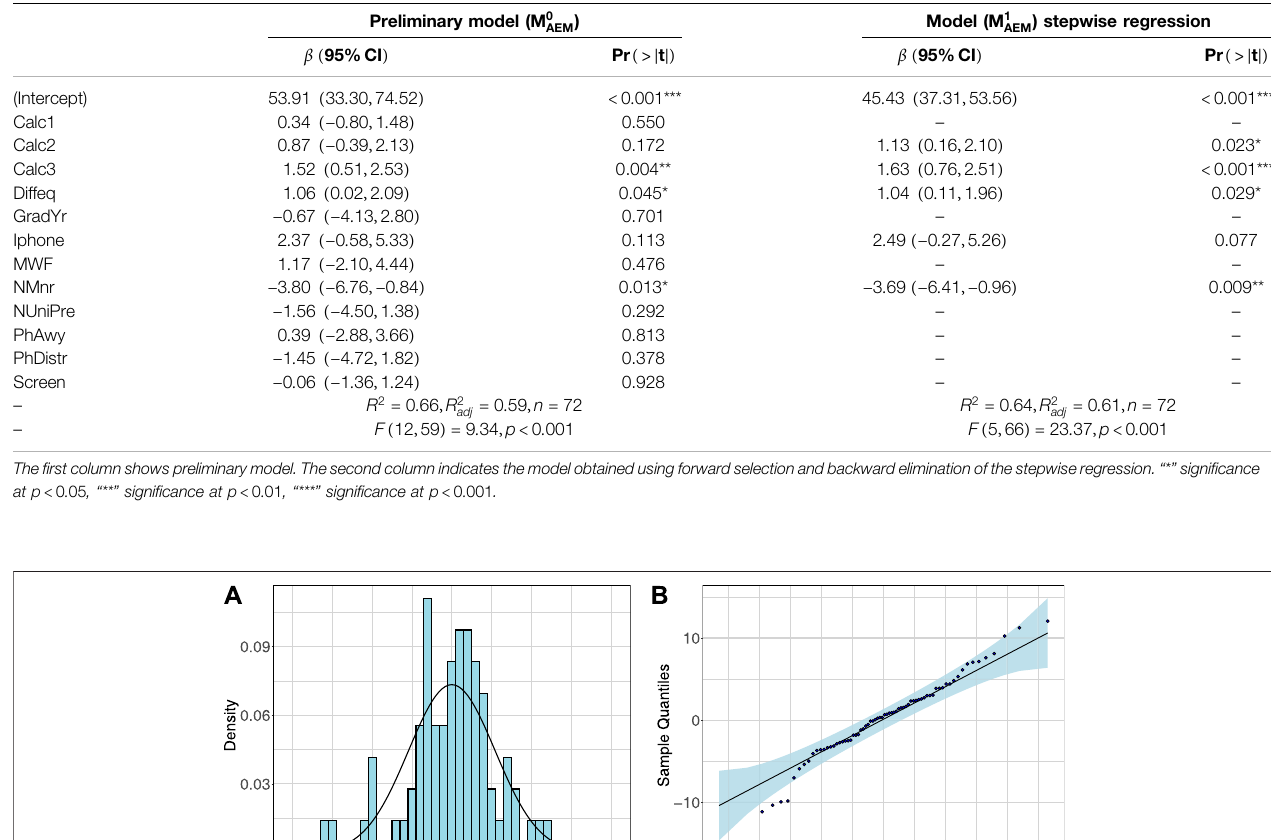
TABLE 4 | Linear models with grades in Advanced Engineering Mathematics as response variables. Linear regression models with grades in AEM as a response